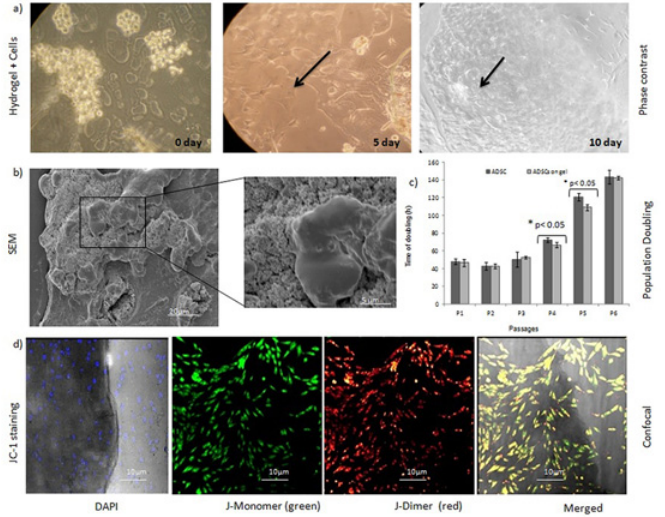
Fig 3. Proliferation potential of hADSCs on chitosan hydrogel. a) hADSCs cultured on chitosan hydrogel on different days. Magnification 200X. b) SEM imaging revealed uniform distribution of hADSCs on the hydrogel. Further, the cells were growing in close association with the hydrogel. c) The mean ± SD values for PDT were low when cells were grown on a hydrogel matrix. There was a significant difference in growth rates of the hADSCs on the hydrogel matrix at P < 0.05 (n = 3). d) JC-1 staining showed JC-1 dimer formation within the stem cell network, thereby indicating the presence of metabolically active live cells on the hydrogel using CLSM. The JC-1 staining of cells differentiate dead from viable intact cells by their mitochondrial membrane integrity. The negative charge established by the intact mitochondrial membrane potential allows the lipophilic dye, to enter the mitochondrial matrix where it accumulates. When the critical concentration is exceeded, J-aggregates form, which appear as fluorescent orange. In non-viable cells, the mitochondrial membrane potential collapses, and the JC-1 cannot accumulate within the mitochondria. The bright field image shows actively growing stem cells present in the hydrogel (n = 3).